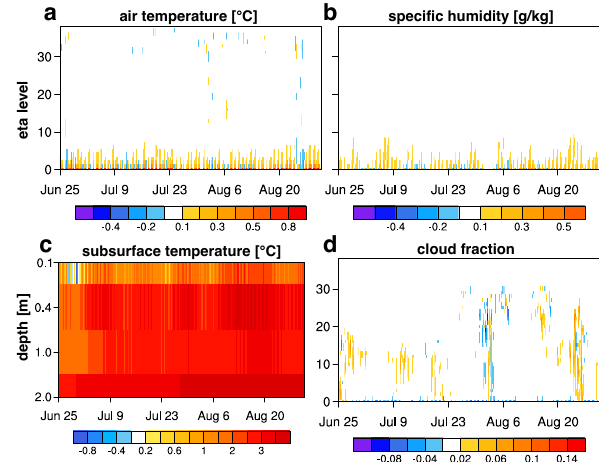
Fig. 6. Vertical and subsurface distribution of the influence of inter- active coupling over glaciated areas illustrated by hourly time series of the change (INT-OFF) in area-averaged (a) air temperature, (b) specific humidity, (c) subsurface temperature, and (d) cloud frac-